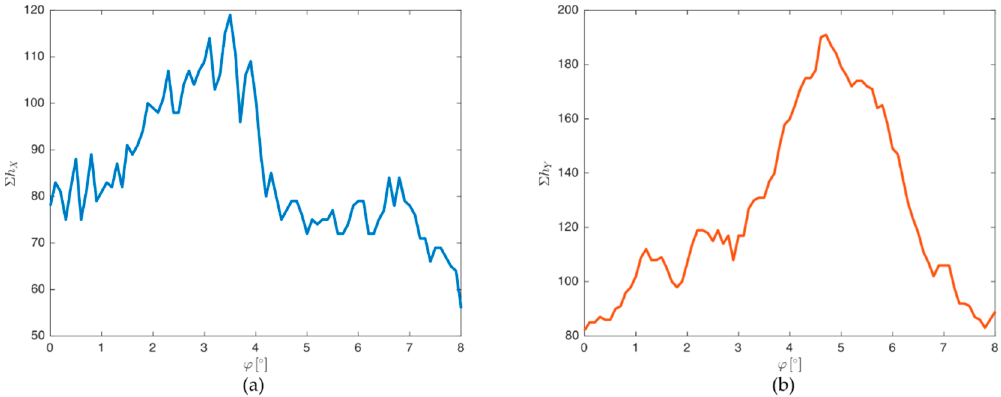
Figure 8. Sum of local maxima of the X and Y axes histograms: ( a ) X-axis sum; ( b ) Y-axis sum.